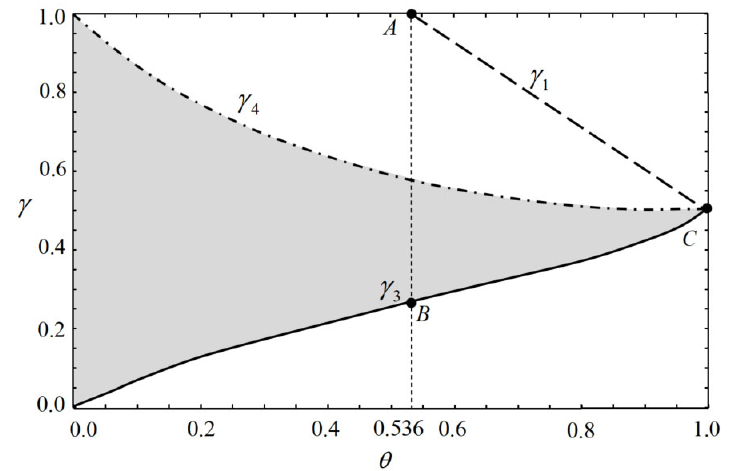
Figure 4. The relationship between consumption market loss rate and market competition